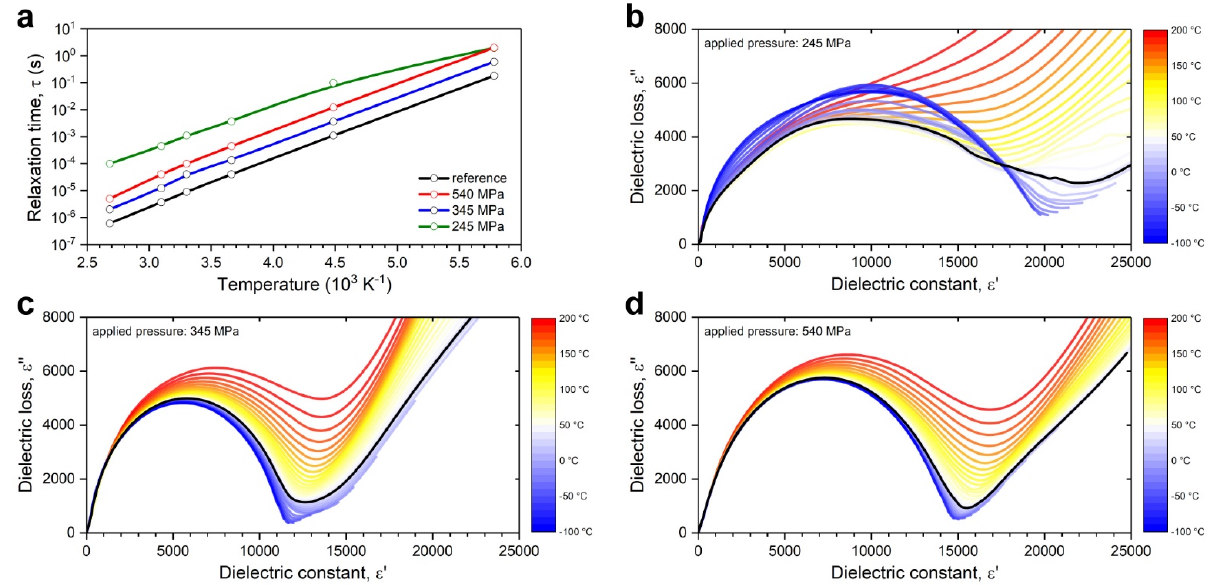
Figure 12. ( a ) Relaxation time τ over scaled reciprocal temperature for all in-lab prepared NASICON samples compared with the commercial reference; Cole ‐ –Cole plots of dielectric loss against dielectric constant for temperatures ranging from 200 °C to − 100 °C for NASICON pellets assembled by applying pressure levels of ( b ) 245 MPa, ( c ) 345 MPa, and ( d ) 540 MPa. Temperature profiles were plotted according to the common colormaps displayed to the right of the figures; scans corresponding to RT (25 °C) are highlighted in bold.